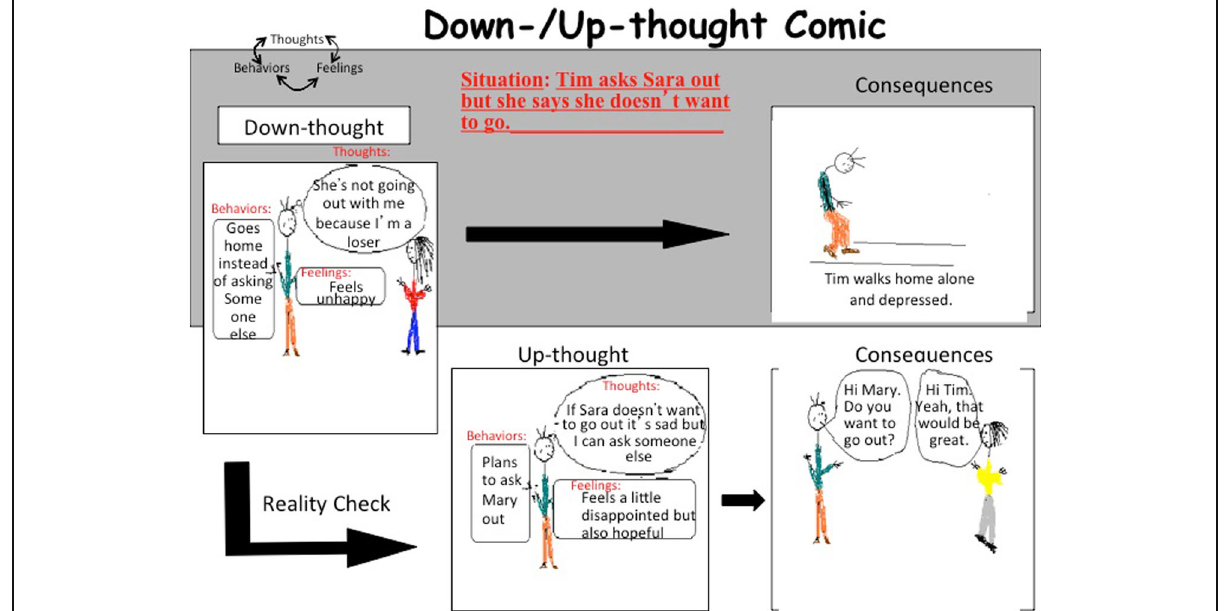
Fig. 8 Example of the down/up-thought comic used in the